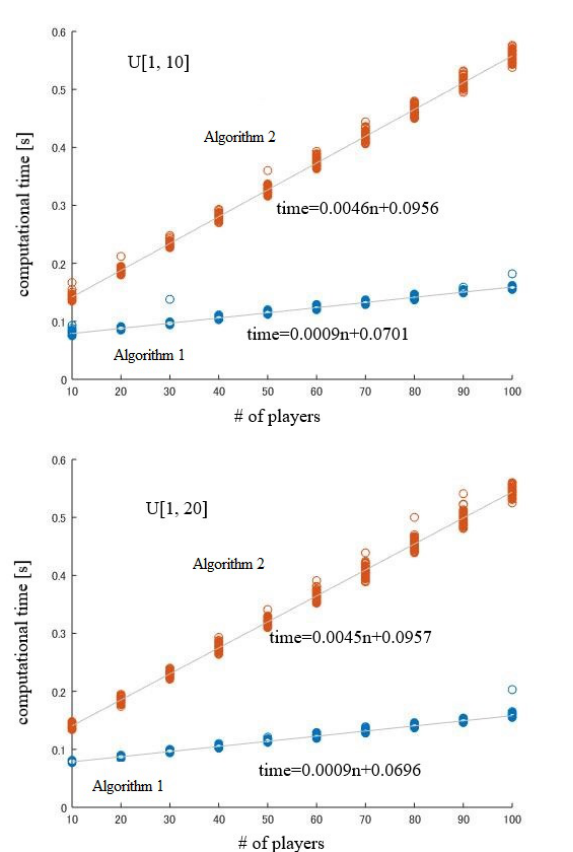
Figure 4. Computational